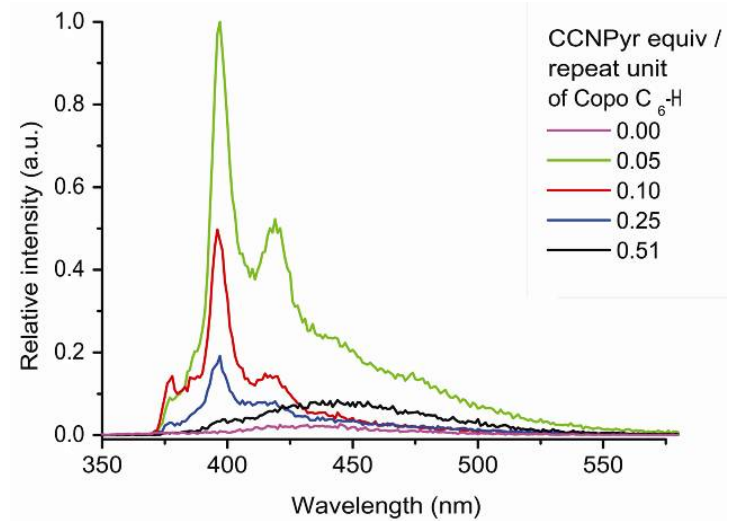
Figure 5. Photoluminescence spectra (emission mode, excitation at 317 nm) of “guest-host” materials Copo C -H/CCNPyr in the solid 6